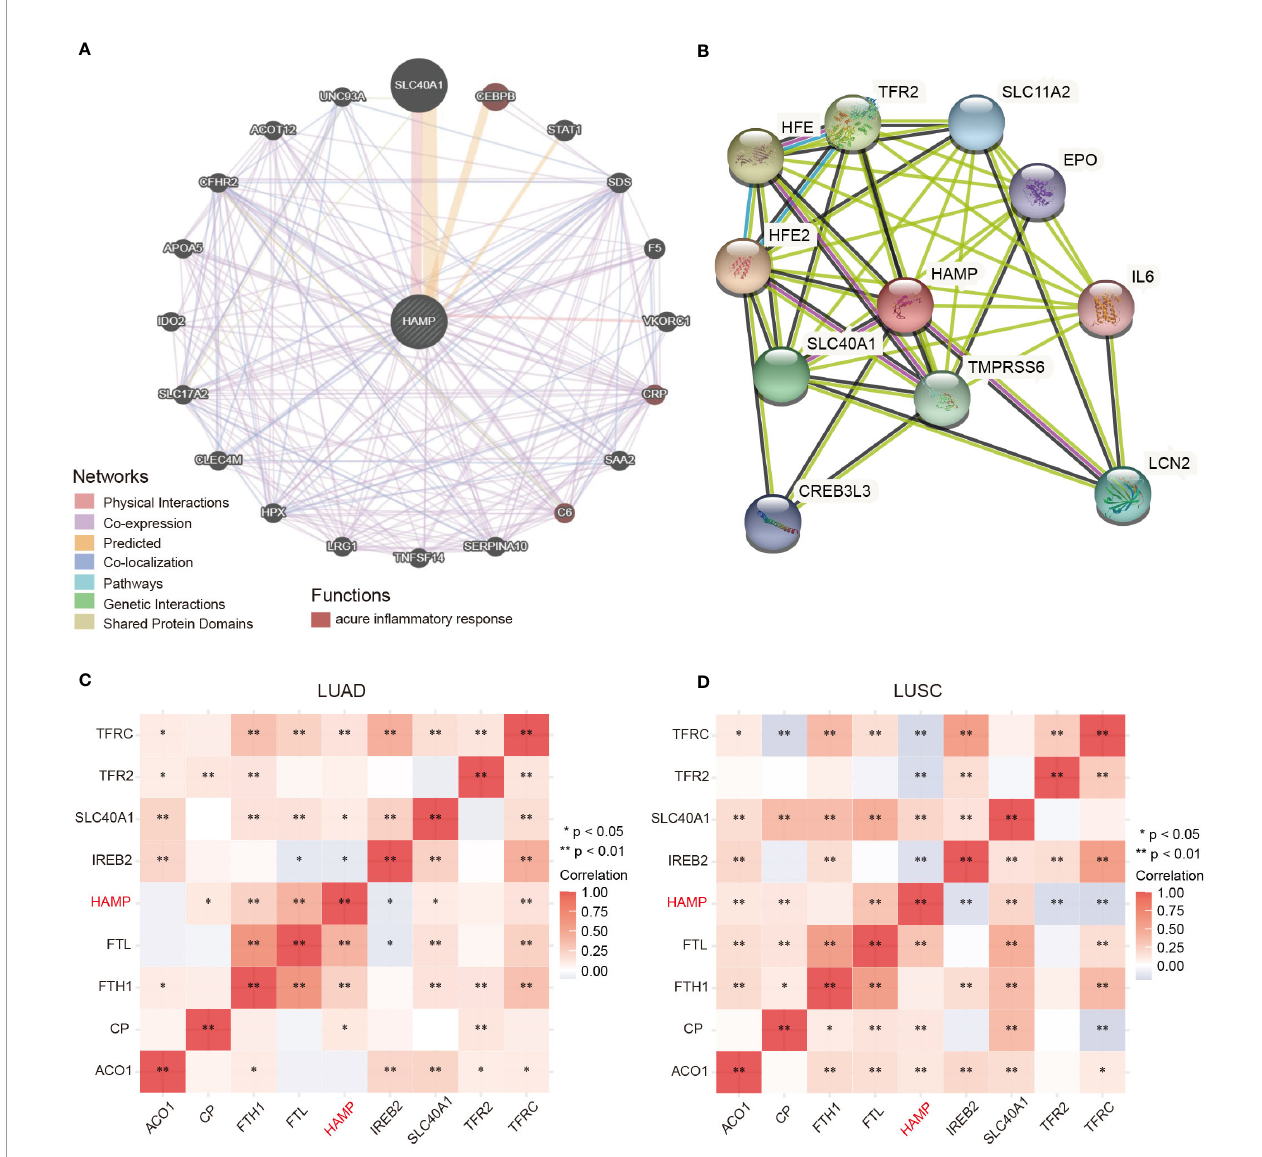
FIGURE 5 | (A) The gene-gene interaction network of hepcidin was constructed using GeneMania. (B) The PPI network of hepcidin was generated using STRING. (C, D) A heat map shows the correlations between hepcidin and iron metabolism-related genes in LUAD and LUSC, respectively. *p < 0.05, **p <